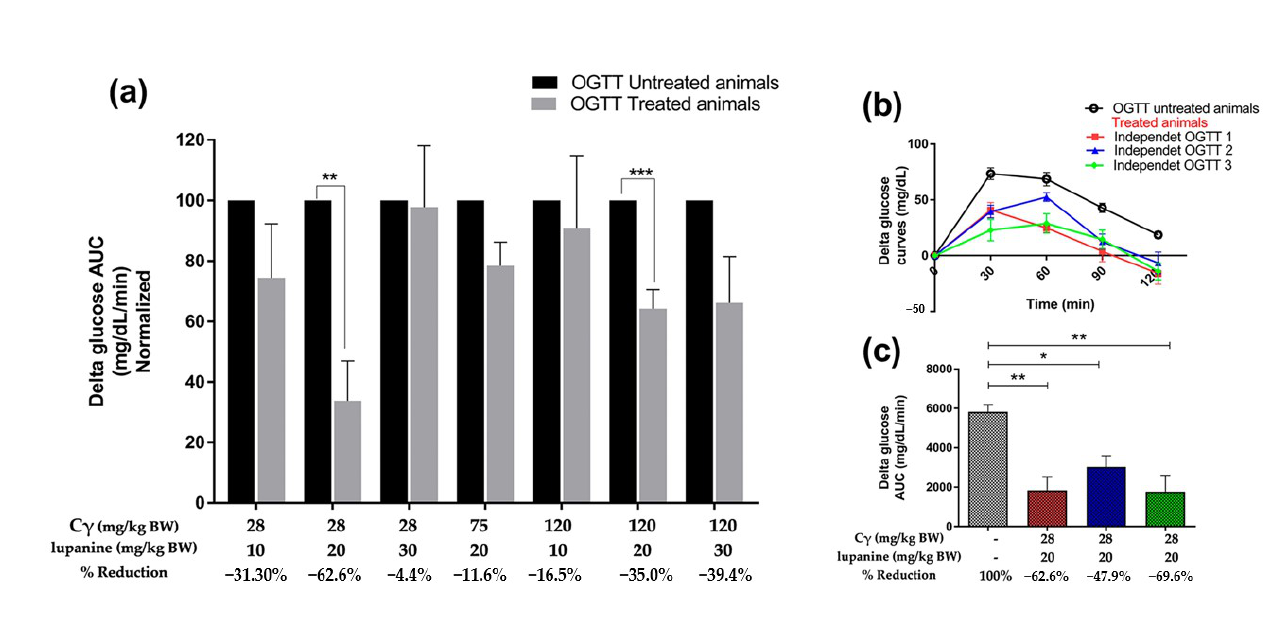
Figure 1. Glycemia reduction effect (percentage) of the different dose combinations of C γ + lupanine. ( a ) OGTTs were performed with and without treatment in the same animal group. Delta glucose AUC values from untreated rats were normalized as 100%. Consequently, delta glucose AUC values from treated rats and the effect on glycemia reduction were calculated. ( b ) Glycemia reduction effect of 28 mg/kg BW C γ + 20 mg/kg BW lupanine on healthy rats ( n = 4) was confirmed in three independent experiments. Delta glucose curves obtained from OGTTs. ( c ) Delta glucose AUC (percentage) of three independent assays. Data were analyzed using a paired t -test. * p < 0.05, ** p < 0.01, *** p < 0.001.